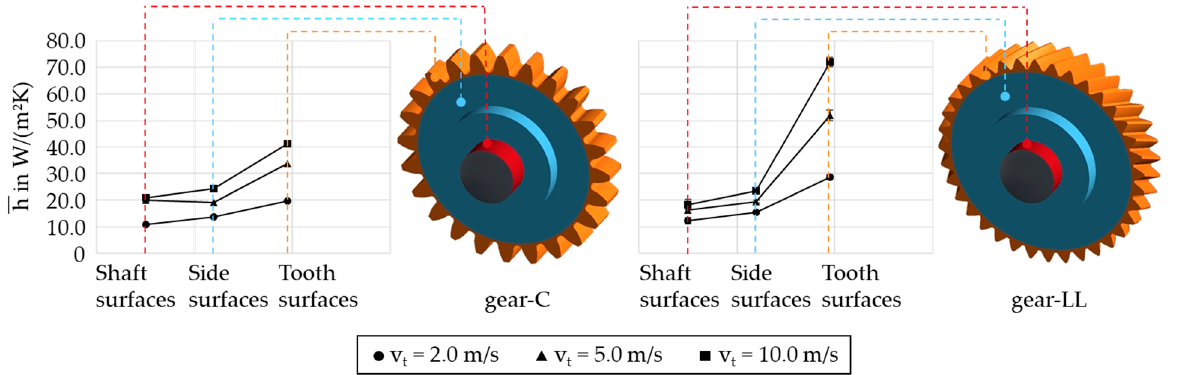
Figure 10. Surface-averaged HTC ℎ for shaft, side, and tooth surfaces for the wheel of gear-C and gear-LL for circumferential speeds v t = {2.0; 5.0; 10.0} m/s.